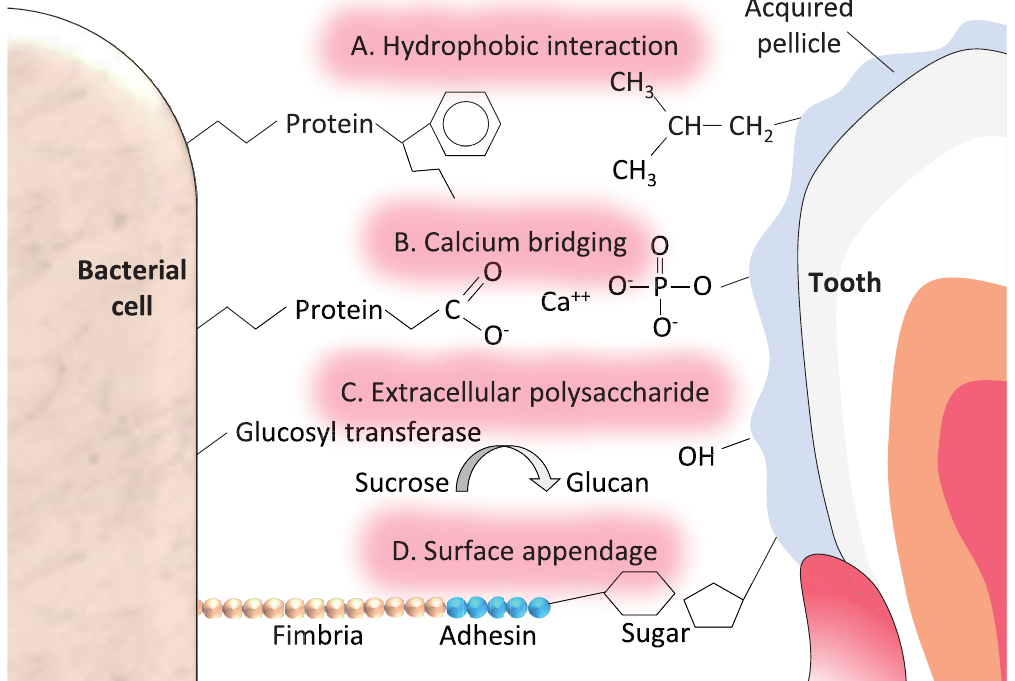
Figure 1. Possible molecular mechanisms underlying bacterial attachment to teeth during dental plaque formation. A. Hydrophobic interaction (between a side chain of a phenylalanine component of a bacterial protein and a side chain of a leucine component of a salivary glycoprotein in the acquired pellicle). B. Calcium bridging (between a negatively charged carboxyl group of a bacterial protein and a positively charged calcium ion, i.e., electrostatic attraction). C. Extracellular polysaccharide (the host’s dietary sucrose is converted by bacterial glucosyltransferase to glucan, which has many functional groups and can interact with amino acid side-chain groups (serine, tyrosine, and threonine). D. Surface appendages (bacterial fimbria extend to permit the terminal adhesin portion to bind to a sugar component of a salivary glycoprotein in the acquired